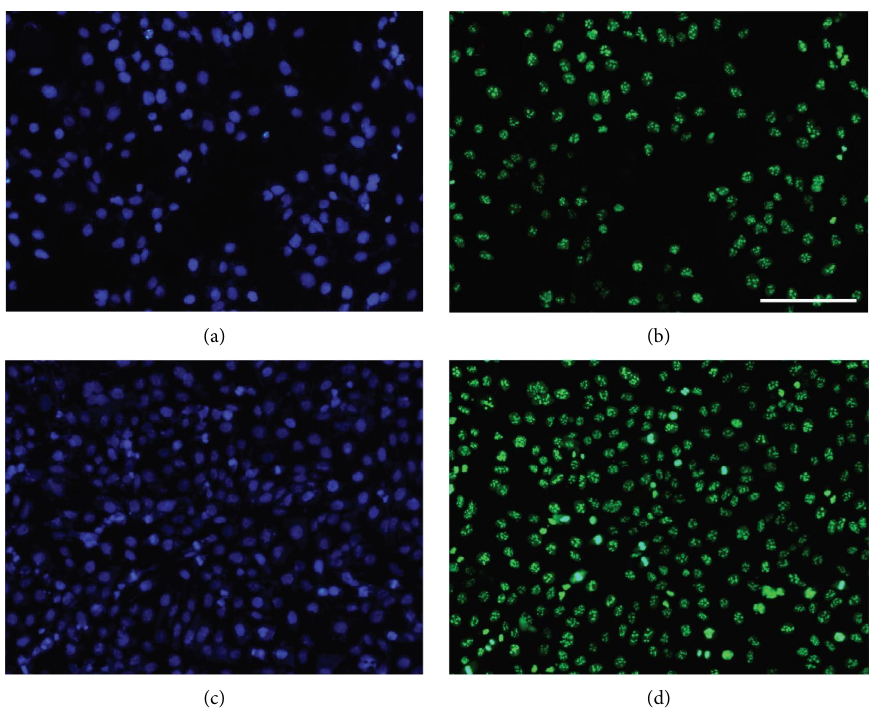
Figure 7: Immunocytochemistry discloses intense nuclear staining for the proliferation marker Ki67 in HaCaT cells stimulated with 10% FBS. (a–d) Cells were incubated in the FBS-free culture medium for 8h to standardize the experimental conditions and then stimulated with either low (0.1%, (a, b)) or high (10%, (c, d)) concentration of FBS for 24h HaCaTcells were cultured on coverslips and fxed. Te same cells were double stained for nuclei using the nuclear marker DAPI (a, c) and for Ki67 immunoreactivity (b, d). Bar in panel (b) represents 150 μ m for all panels. Each sample was analyzed in